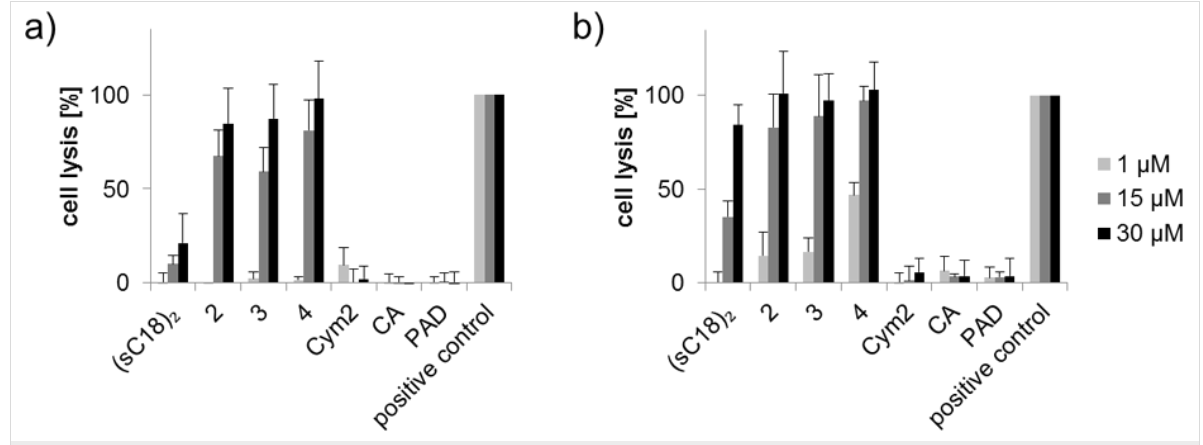
Figure 9: Cell lysis of (a) HT-29 and (b) MCF-7 cells induced by the (sC18) 2 conjugates at different concentrations after 1 h incubation. Experiments were conducted in triplicate with n = 2. Error bars represent the standard deviation.